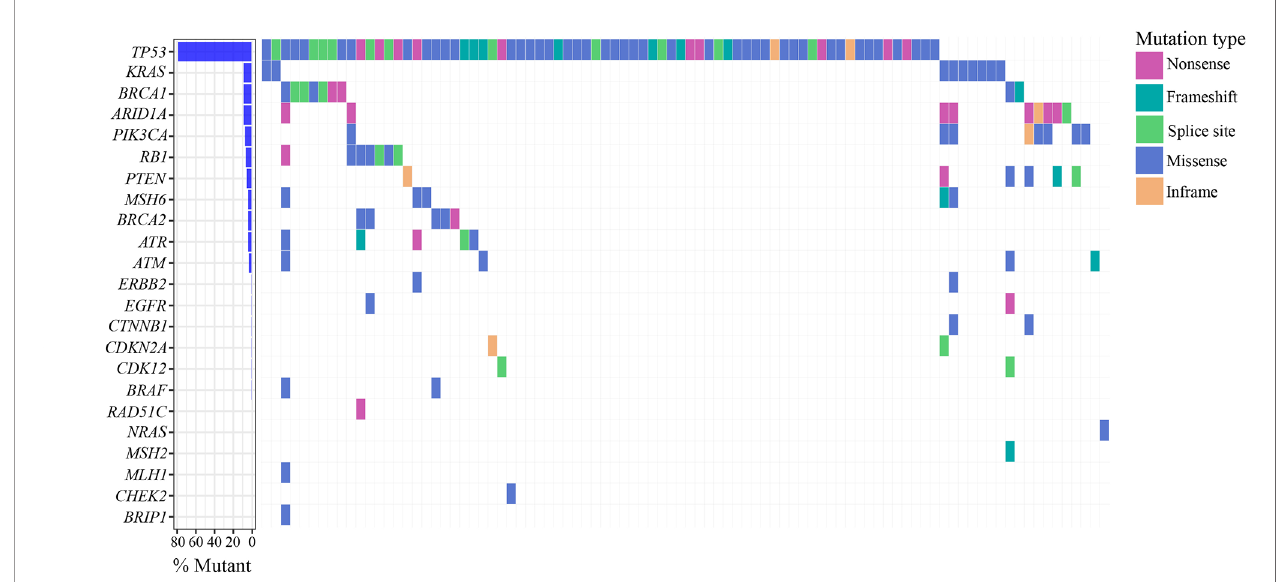
FIGURE 2 | Spectrum of somatic variants identi fi ed in ovarian tumor